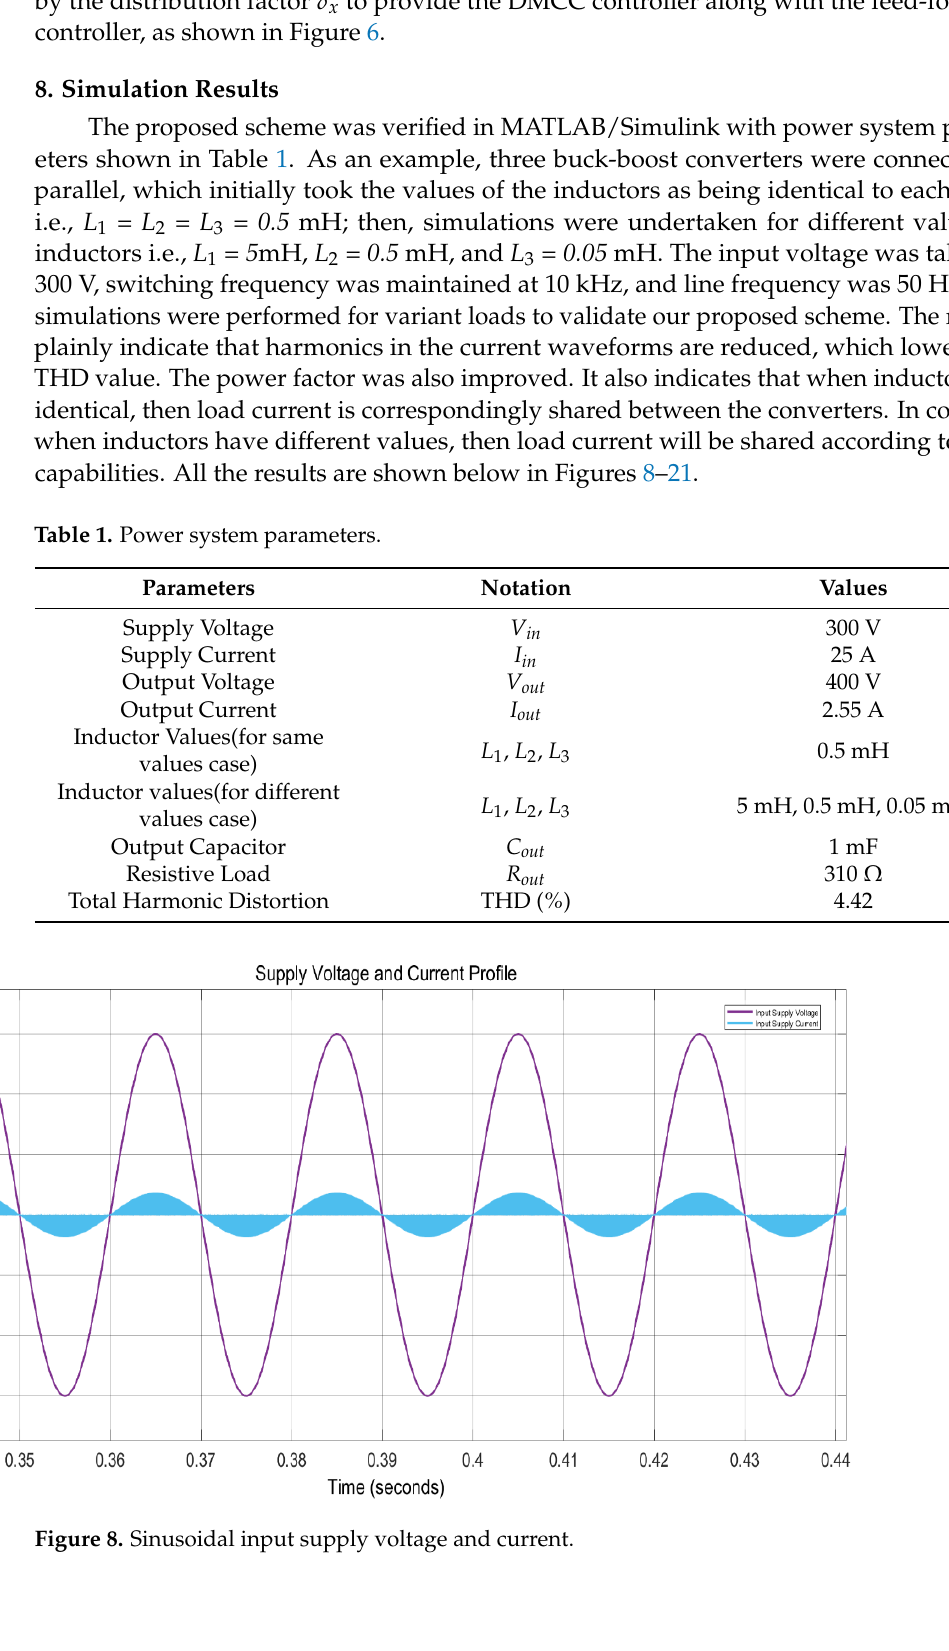
Figure 9. Output voltage profile.